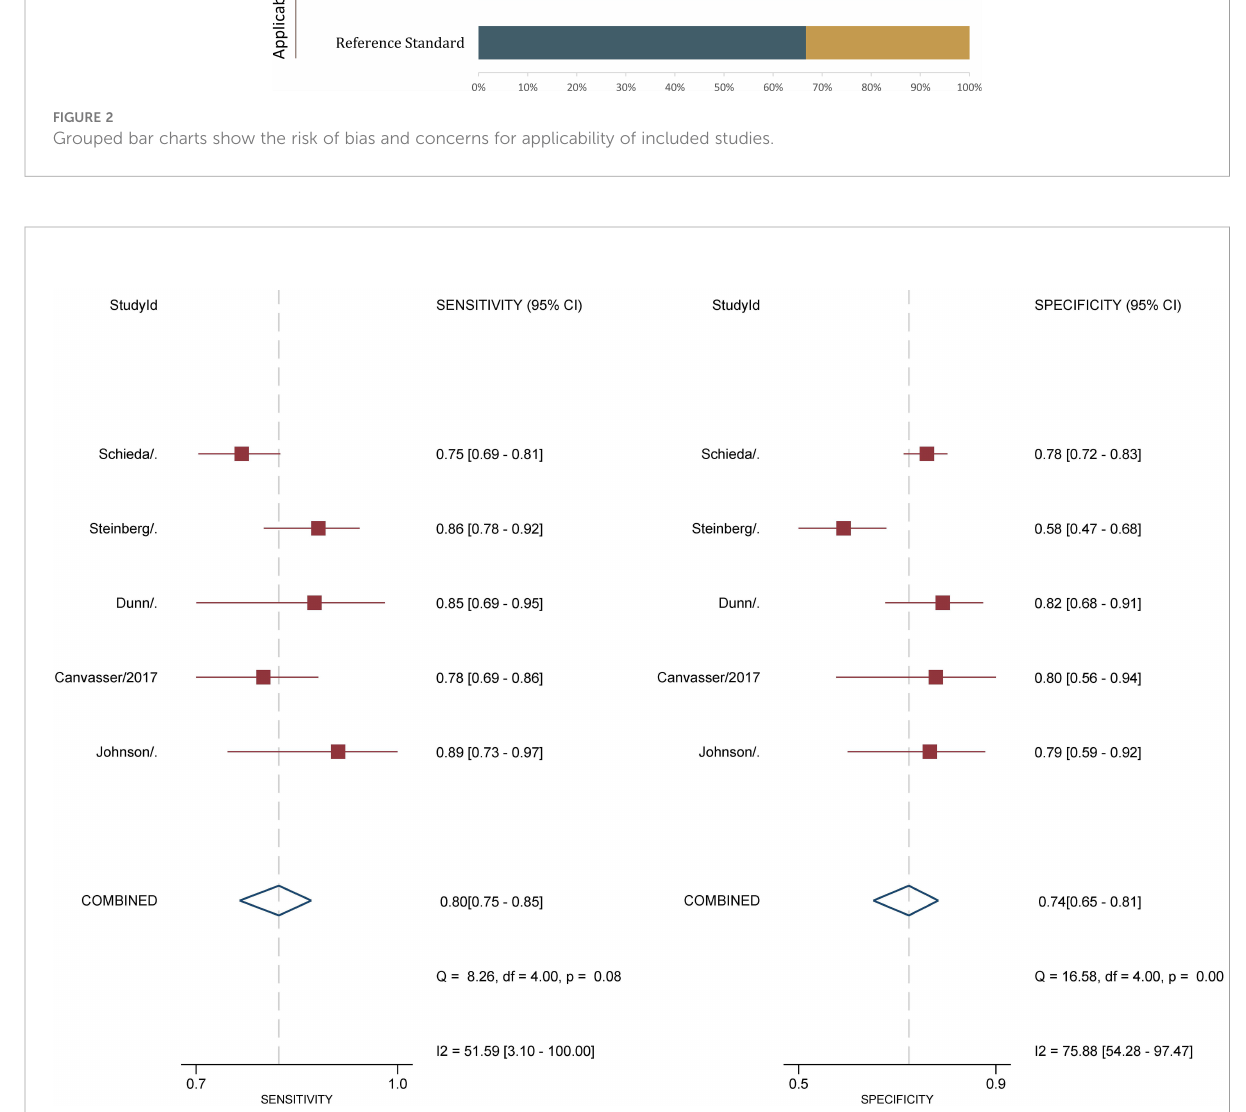
FIGURE 3 Coupled forest plot of pooled sensitivity and speci fi city. Numbers are pooled estimates with 95% CI in parentheses. Corresponding heterogeneity statistics are provided at bottom right corners. Horizontal lines indicate 95% con fi dence